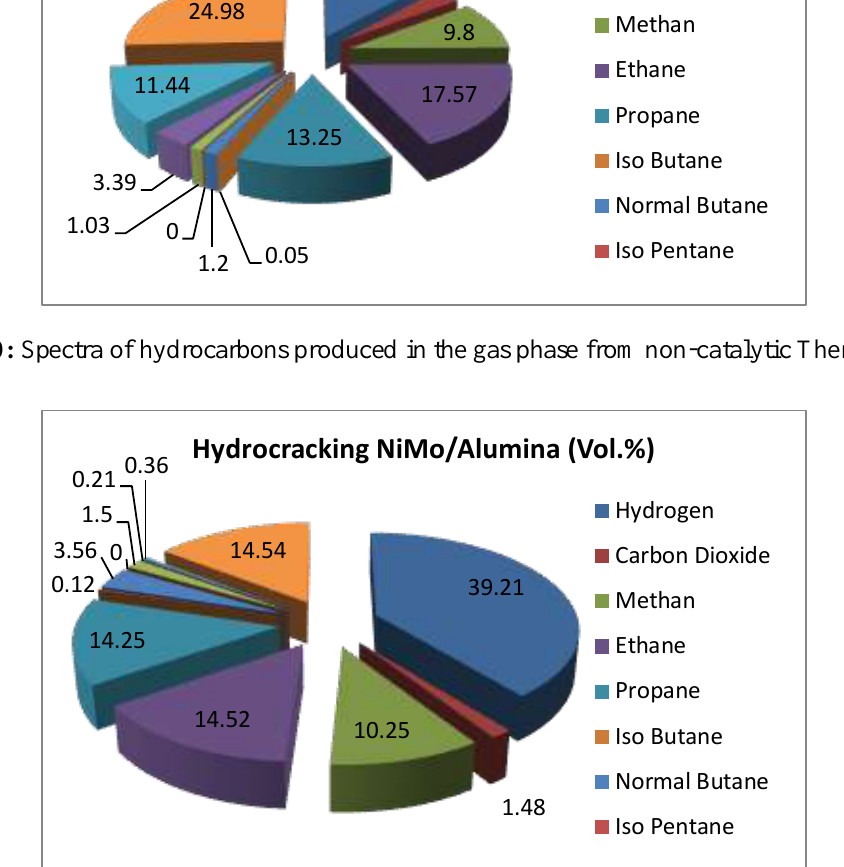
Figure 11: Spectra of hydrocarbons produced in the gas phase from catalytic hydrocracking over NiMo/Al 2 O 3